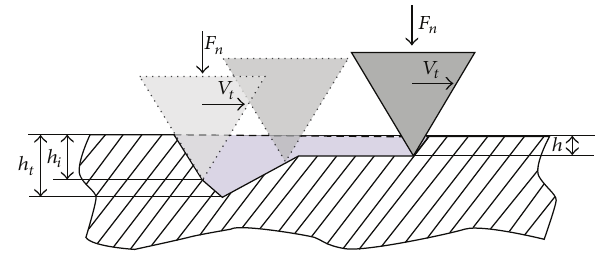
Figure 1: Penetration during load controlled scratch test.